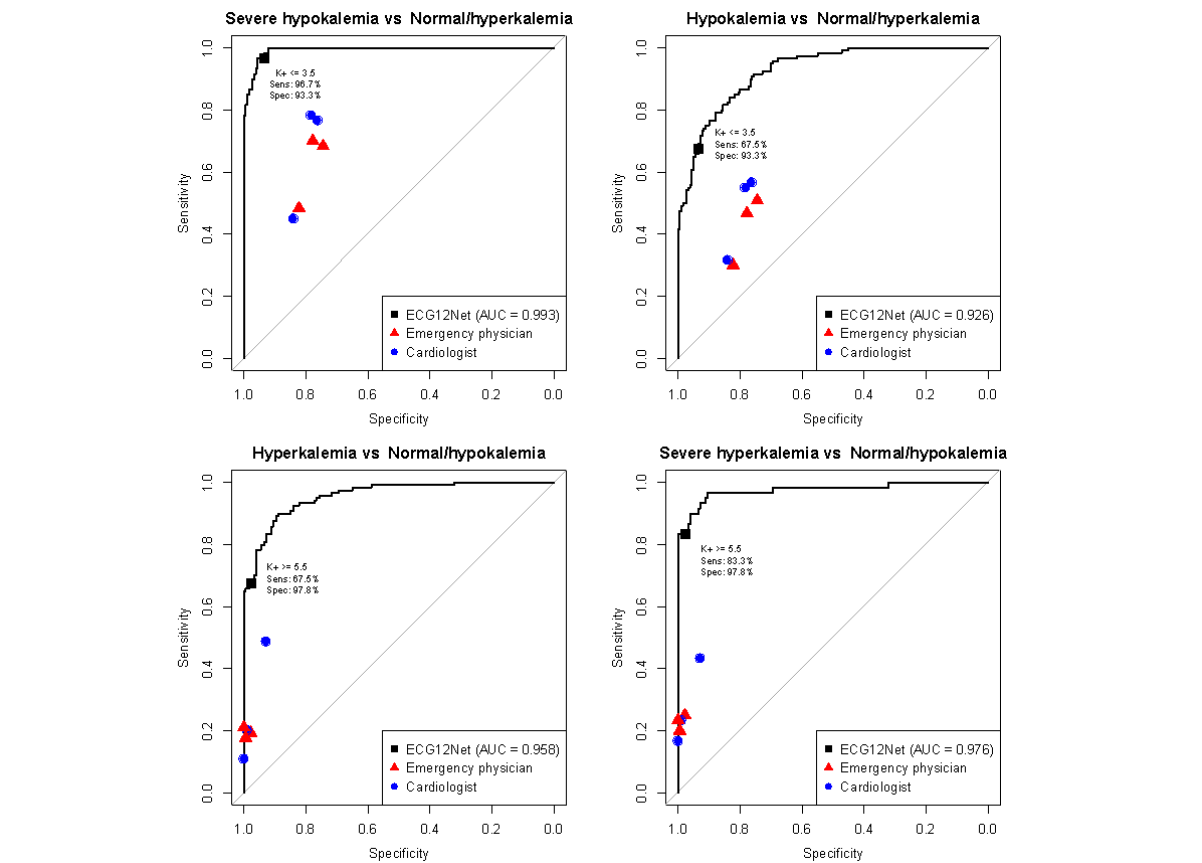
Figure 2. Performance comparison in detecting dyskalemias from the human-machine competition (n=300). The receiver operating characteristic curves are made by the predictions of ECG12Net-1. The red triangles and blue circles indicate emergency physicians and cardiologists, respectively, in the human-machine competition. K + ≤ 2.5 mEq/L, 2.5< K + ≤ 3.5 mEq/L, 3.5< K + <5.5 mEq/L, 5.5 ≤ K + <6.5 mEq/L, and K + ≥ 6.5 mEq/L were defined as severe hypokalemia (n=60), hypokalemia (n=120), normal (n=60), hyperkalemia (n=120), and severe hyperkalemia (n=60), respectively. AUC: area under the